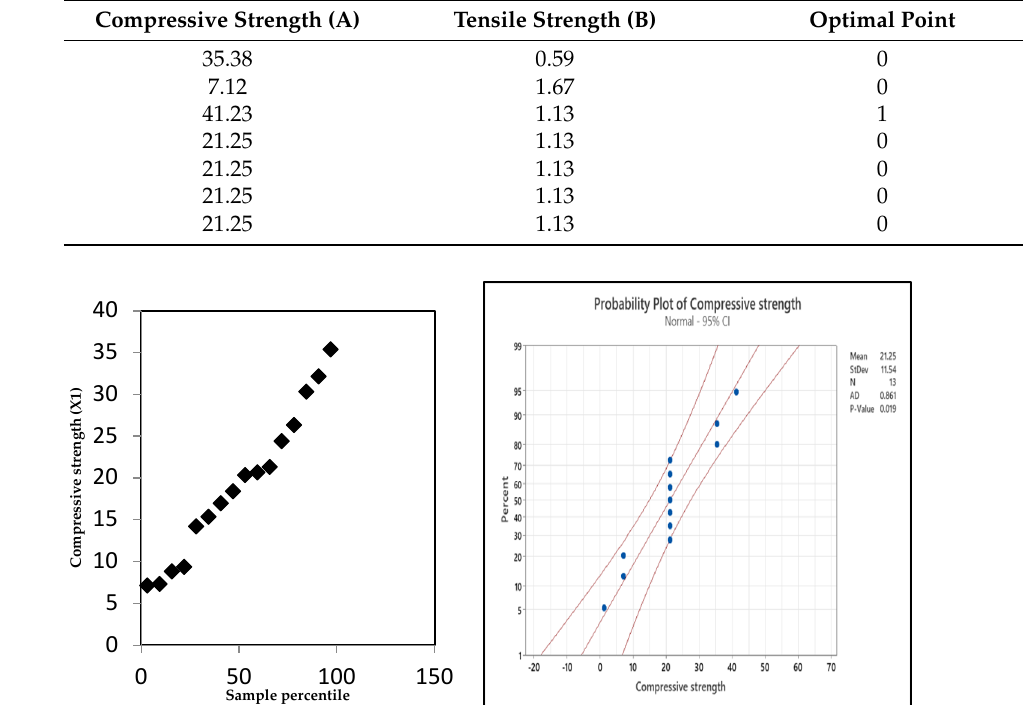
Figure 10. Normal probability plot of compressive strength (X1).